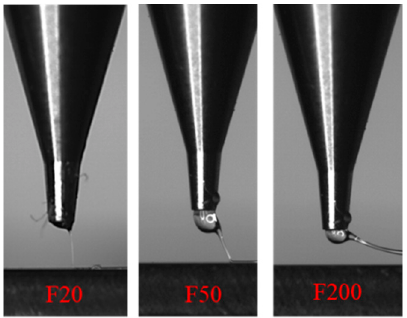
Figure 9. Deposition morphology of jet under different substrate velocities.